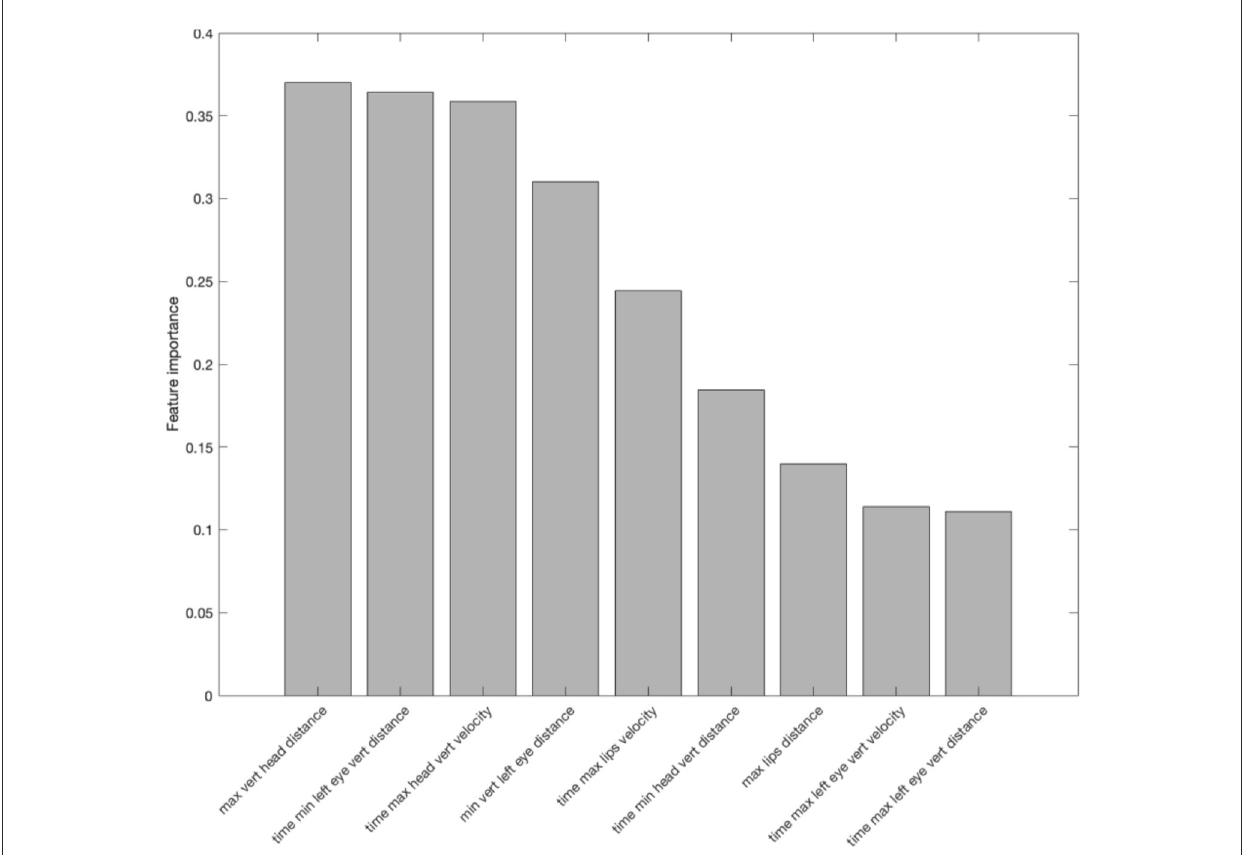
FIGURE8 Important features identified by random forest in differentiating the two speech styles (clear and plain) in Tone 3. The y-axis shows the feature importance measured by the random forest. The feature importance measures the increase in classification error if the values of the feature are permuted. The greater the error the higher the importance of the